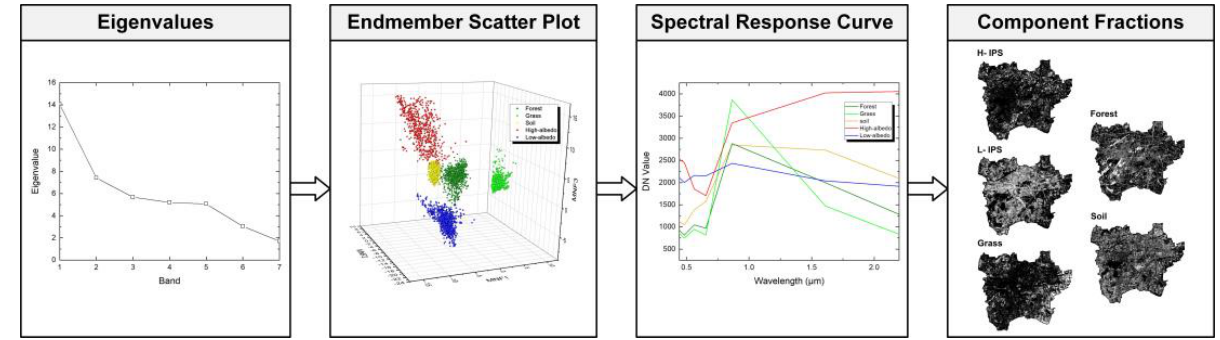
Figure 2. Flow chart of impervious surface (IPS) density extraction (data from 17 May 2020).